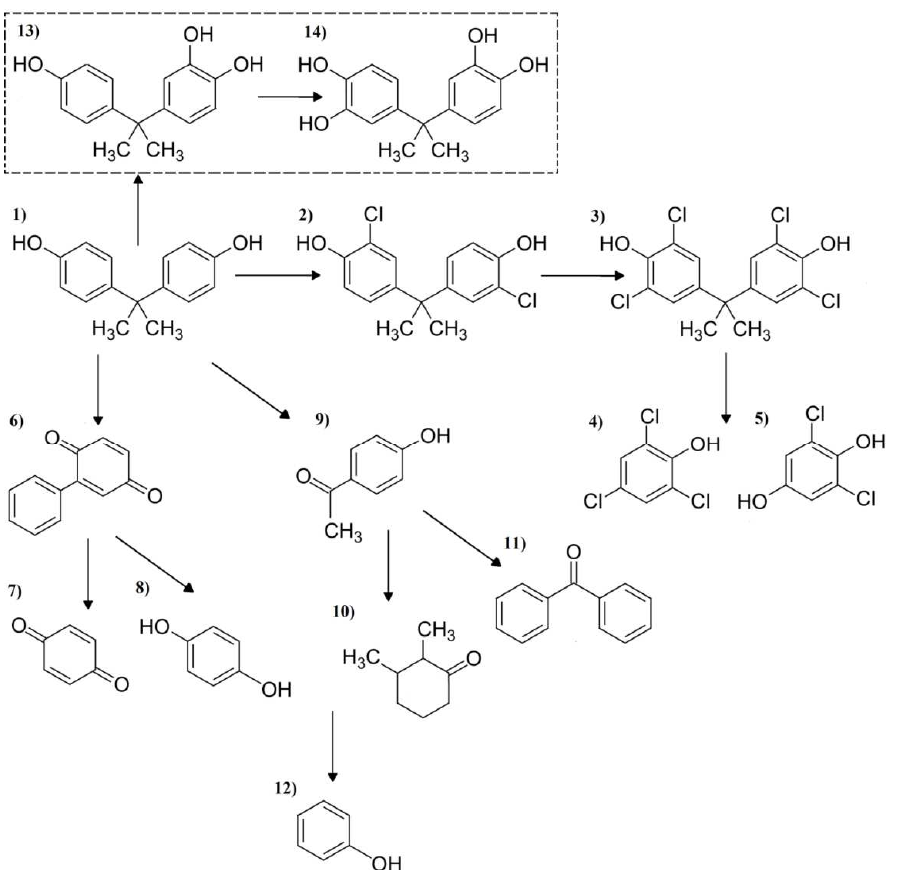
Figure 11. ( 1 ) BPA decomposition by-products: ( 2 ) 3,3 (cid:48) -Dichlorobisphenol A, ( 3 ) Tetrachlorobisphenol A, ( 4 ) 2,4,6-Trichlorophenol, ( 5 ) 2,6-Dichlorohydroquinone, ( 6 ) 2-Phenylbenzoquinone, ( 7 ) Benzoquinone, ( 8 ) Hydroquinone, ( 9 ) p -Hydroxyacetophenone, ( 10 ) 2,3-Dimethylcyclohexanon, ( 11 ) Benzophenone, ( 12 ) Phenol, ( 13 ) MW = 244 5-Hydroxybisphenol and ( 14 ) MW = 262 5,5 (cid:48) -Dihydroxybisphenol.